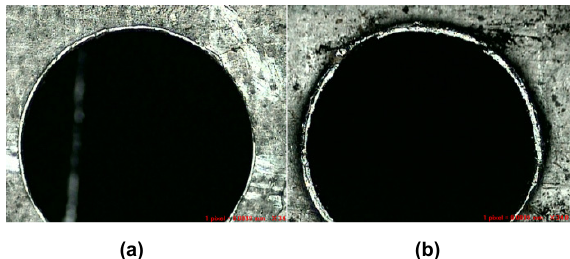
Figure 16. Interactive effect of spindle speed and feed rate on circularity error.